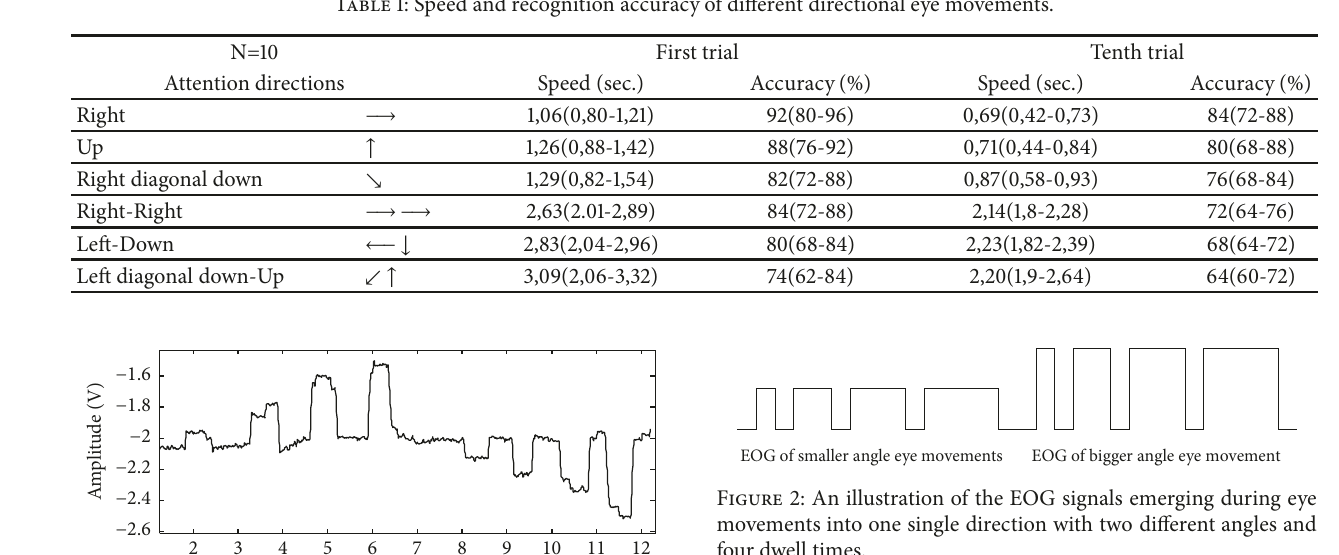
Table 1: Speed and recognition accuracy of different directional eye movements.